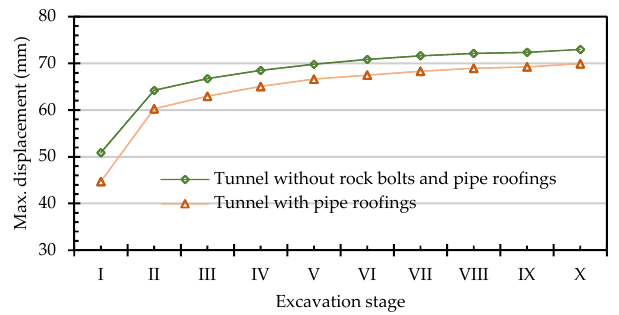
Figure 28. Maximum displacement at various excavation stages.